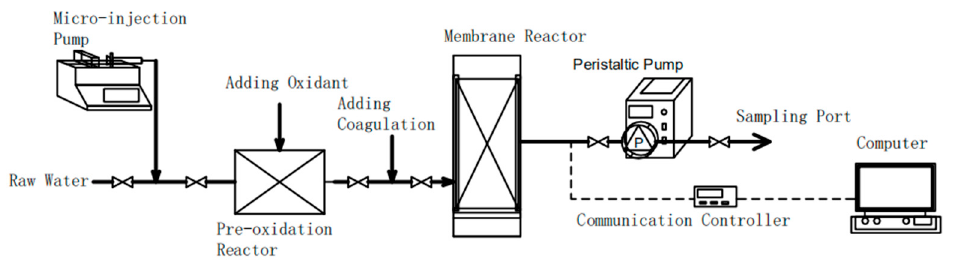
Figure 1. Schematic diagram of the experiment set-up.